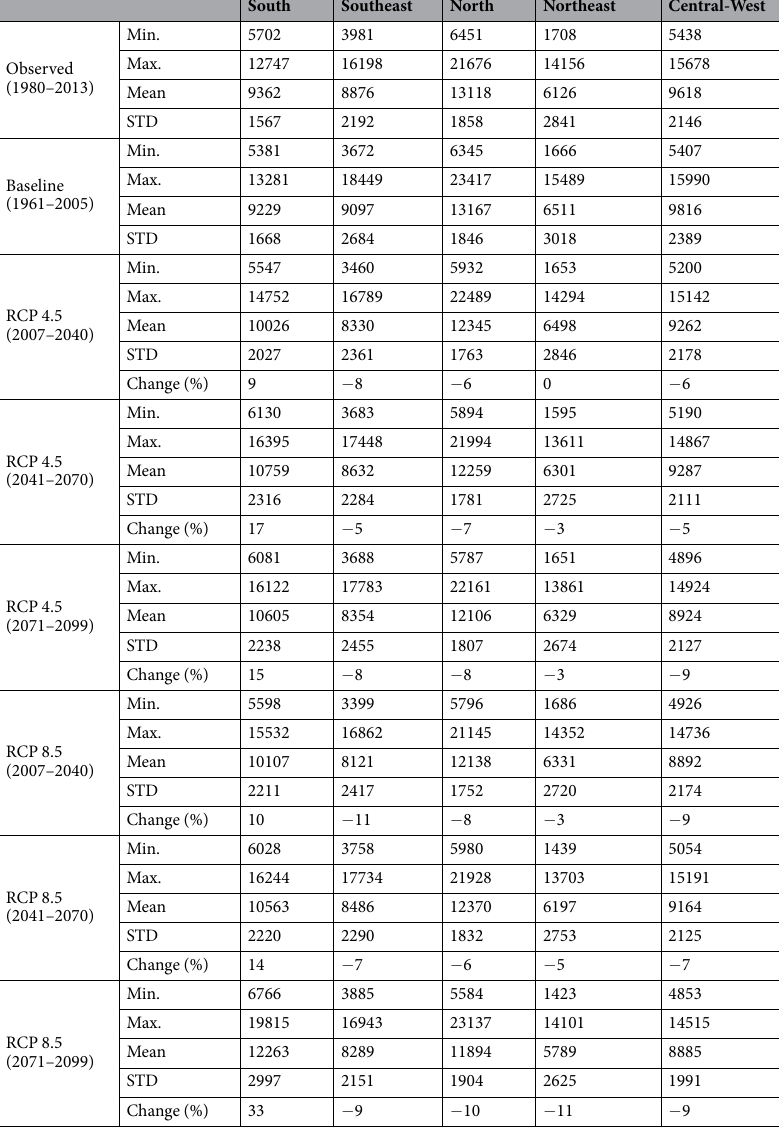
Table 2. Basic statistics of rainfall erosivity in Brazilian regions. Observed and estimated by MIROC5 model. Minimum, maximum, mean, standard deviation (MJ mm ha − 1 h − 1 year − 1 ) and projected change in relation to baseline